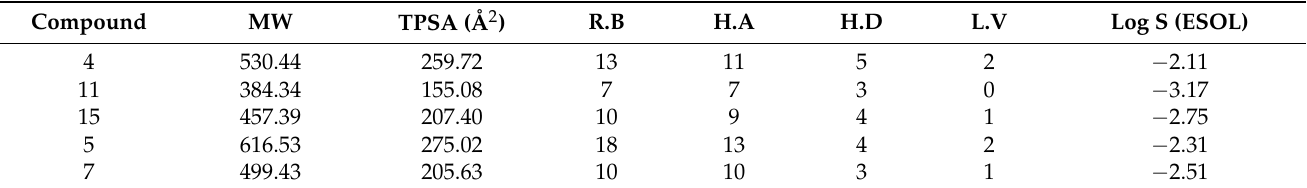
Table 1. Physicochemical properties of the flavonoid acetamide derivatives, based on Swiss